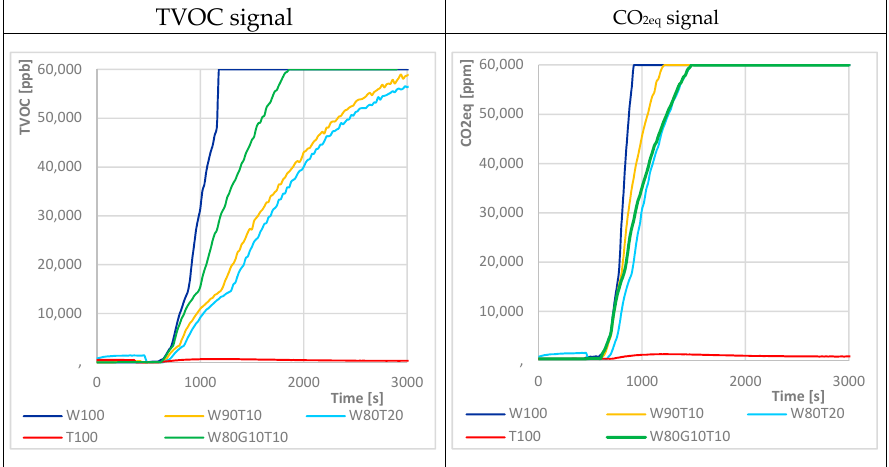
Figure 7. Fermentation process — examples of sensor response SGP-30 for TVOC and CO 2eq signal and for various contents of mealworm flour (W — wheat flour, G — grape pomace flour, T — mealworm flour). Mixed sample inserted at t = 600 s.